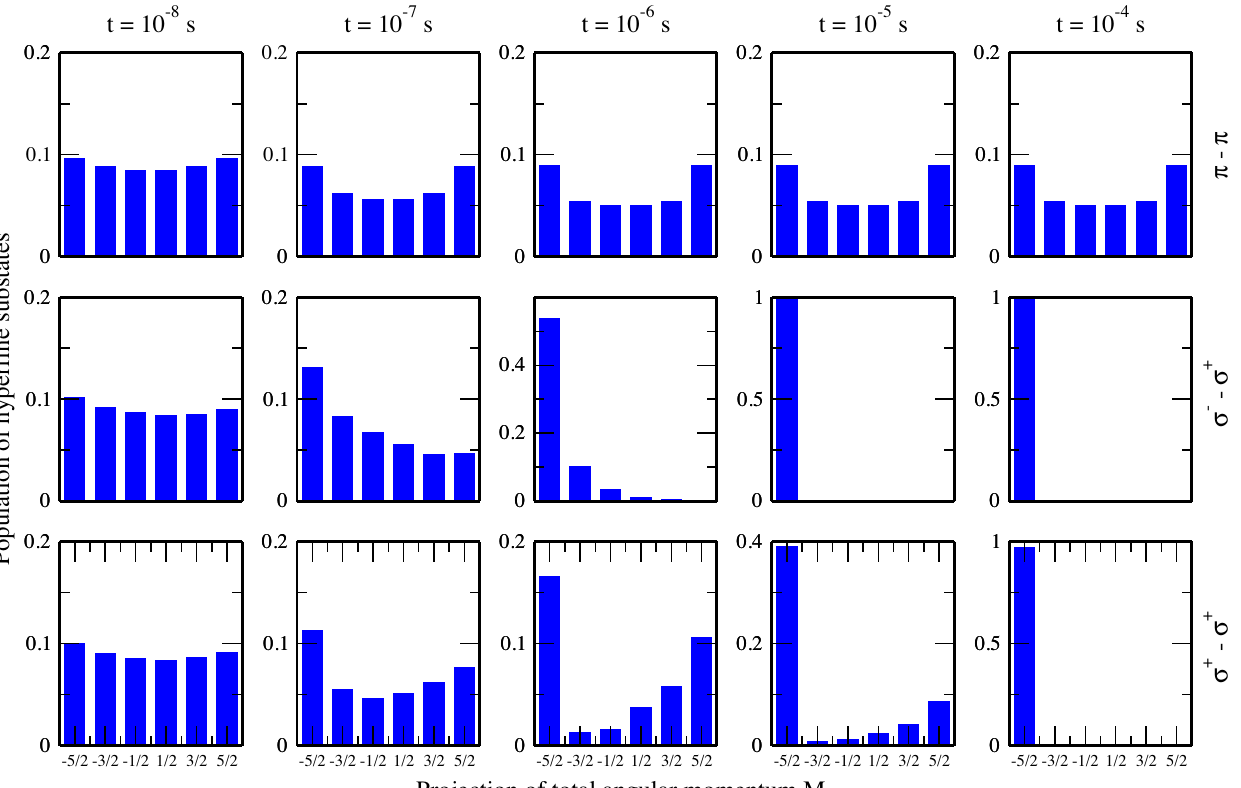
i at times t ¼ 10 − 8 s, t ¼ 10 − 7 s, t ¼ 10 − 6 s, 2